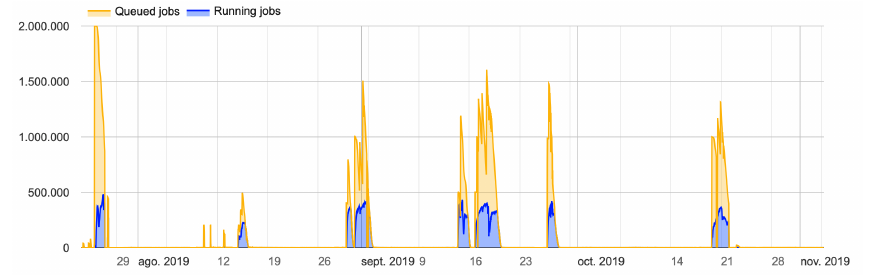
Figure 4. Number of simultaneously running and queued jobs for the scalability tests performed during 2019 on the CMS HTCondor Global Pool. Notice the successive attempts approaching the 500,000 simultaneously running jobs mark, under varying conditions, as described in section